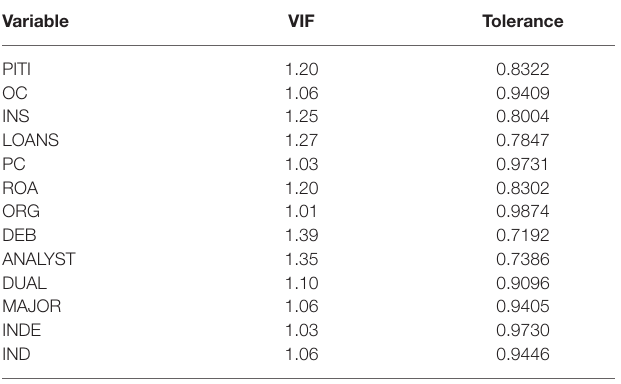
TABLE 6 | Variance inflation factor test for variables. Variable VIF Tolerance PITI